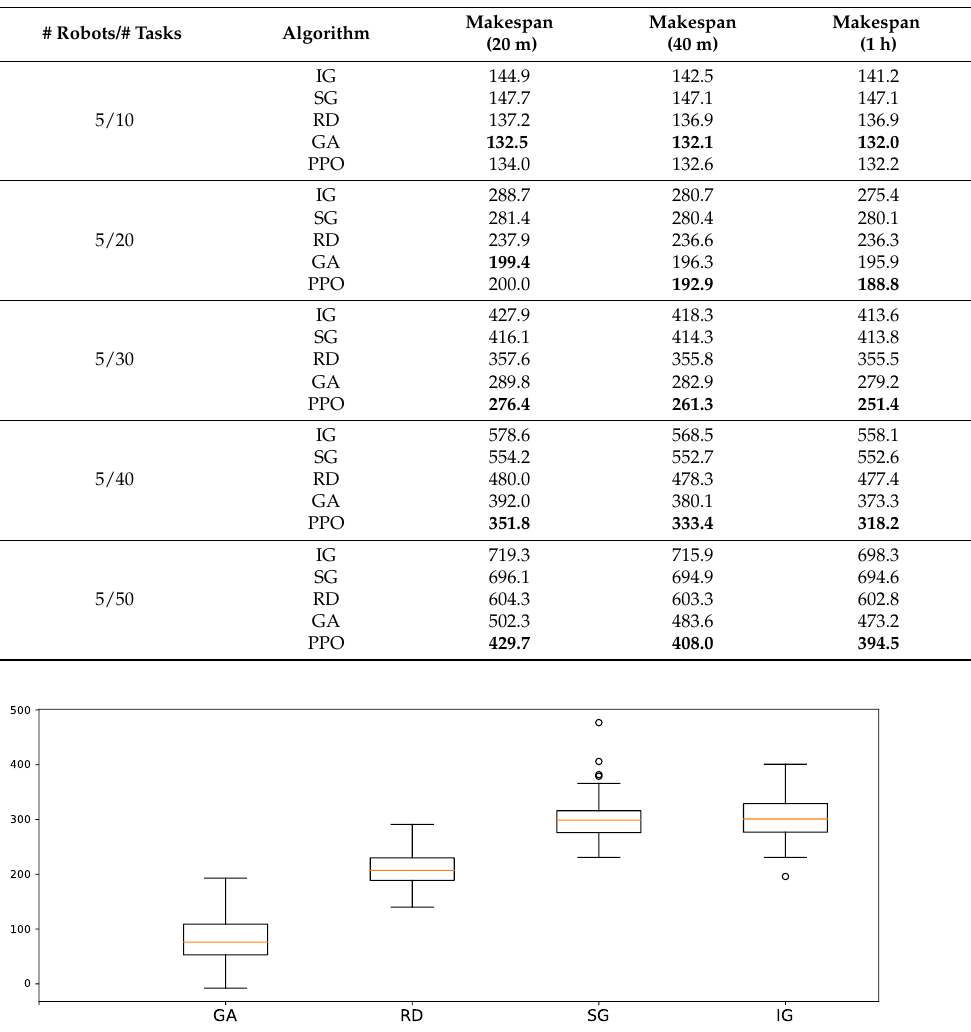
Figure 8. Boxplot of the makespan gap ( makespan meta − makespan PPO ) between PPO and meta- heuristic methods for each 100 samples in 5 robots, 50 tasks, and 1 h